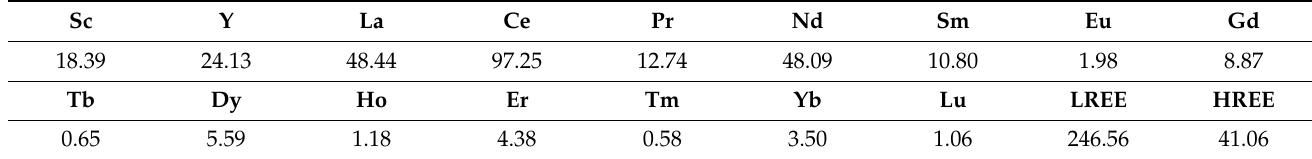
Table 2. XRF analysis of major and minor phases (wt.%) for the 2.20 sink fraction of the Baker seam coal. Table 1. Rare earth element concentration (whole mass basis, ppm) in 2.20 SG sink fraction of Baker coarse refuse material [Ash Content: